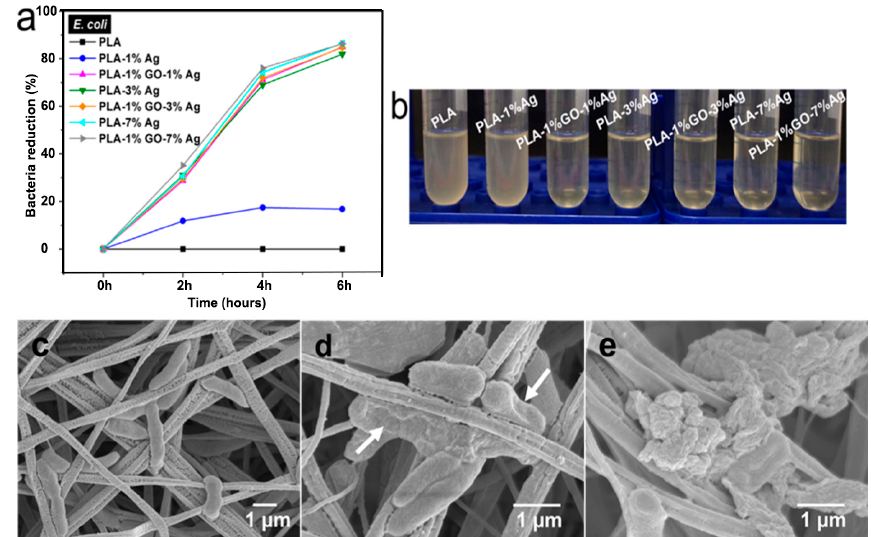
Figure 13. ( a ) Bacterial reduction percentage vs. time profiles for E. coli culture medium treated with PLA and its nanocomposite fibrous mats. The circular disk samples were soaked in the test tubes containing nutrient broth for E. coli (1 × 10 6 CFU/mL), and then placed in a rotary shaker at 37 °C for different time points. ( b ) Photograph of E. coli culture suspensions treated with PLA and its nanocomposite fibrous mats for 6 h. SEM images showing progressive loss of membrane integrity of E. coli attached on PLA/1 wt%GO-3 wt%AgNPs fibers for ( c ) 2, ( d ) 4, and ( e ) 6 h. White arrows indicate ruptured cell membranes. Reproduced with permission from [165], Copyright American Chemical Society, 2017.